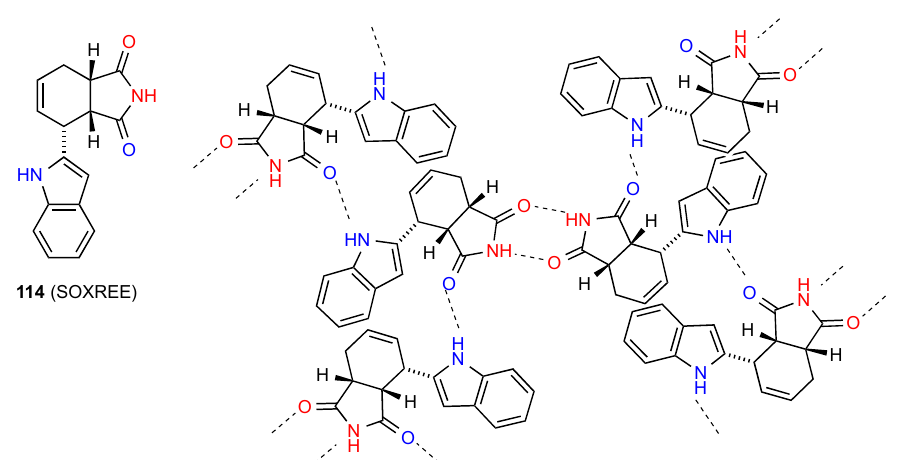
Figure 39. Structure adopted by compound 114.